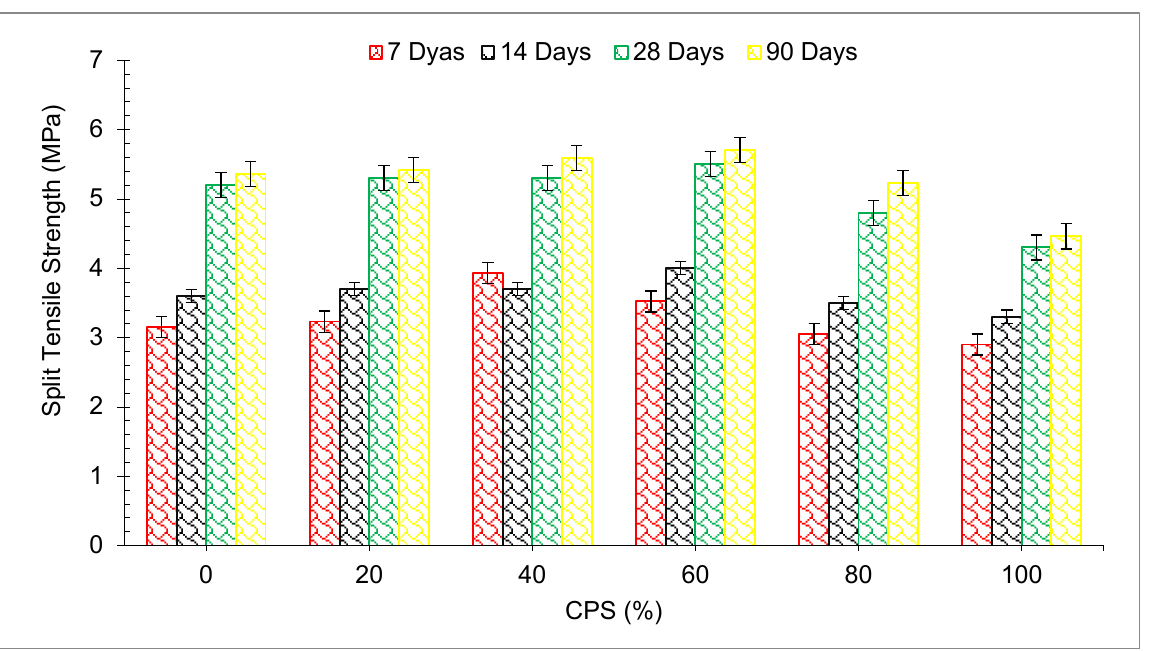
Figure 9. Split tensile strength of concrete [45].